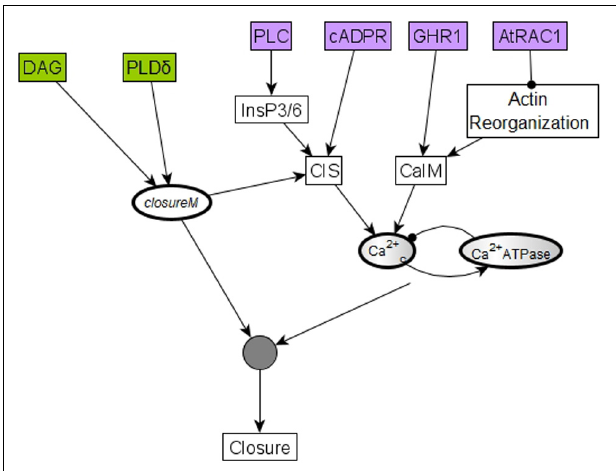
FIGURE 10 | The initial condition of six nodes can lead to temporary closure by helping establish Ca 2 + c oscillations and the closureM conditionally stable motif. Four of these six nodes, cADPR, GHR1, AtRAC1, and PLC, represented in purple, regulate one of the two processes (CIS or CaIM) that yield Ca 2 + c elevation. For example, the two-edge path between AtRAC1 and CaIM indicates that AtRAC1 inhibits the reorganization of the actin cytoskeleton that otherwise would contribute to Ca 2 + influx (CaIM). Ca 2 + c elevation, in turn, has some probability of causing Ca 2 + c oscillations due to the negative feedback loop formed by Ca 2 + c and Ca 2 + c ATPase. These oscillations have a potential to drive the network to the closed stomata attractor. The remaining two nodes, PLD δ and DAG, represented in green, affect the closureM motif, indicated by the edges that start from PLD δ and DAG, respectively, and end in the node that stands for the closureM motif. Both nodes are direct regulators of PA, which is an internal driver of the motif, thus their activity has a chance of locking in the closureM motif. The stabilization of the closureM motif is sufficient for sustained Ca 2 + c oscillations, indicated by the path mediated by CIS. The cumulative effect of sustained Ca 2 + c oscillations and of the closureM motif leads to stomatal closure (see Section “Stable Motif Succession Diagrams of the Stomatal Closure Model Versions”). Hence, initiating any of these six nodes in their states corresponding to stomatal closure leads to a non-zero percentage of stomatal closure, at least